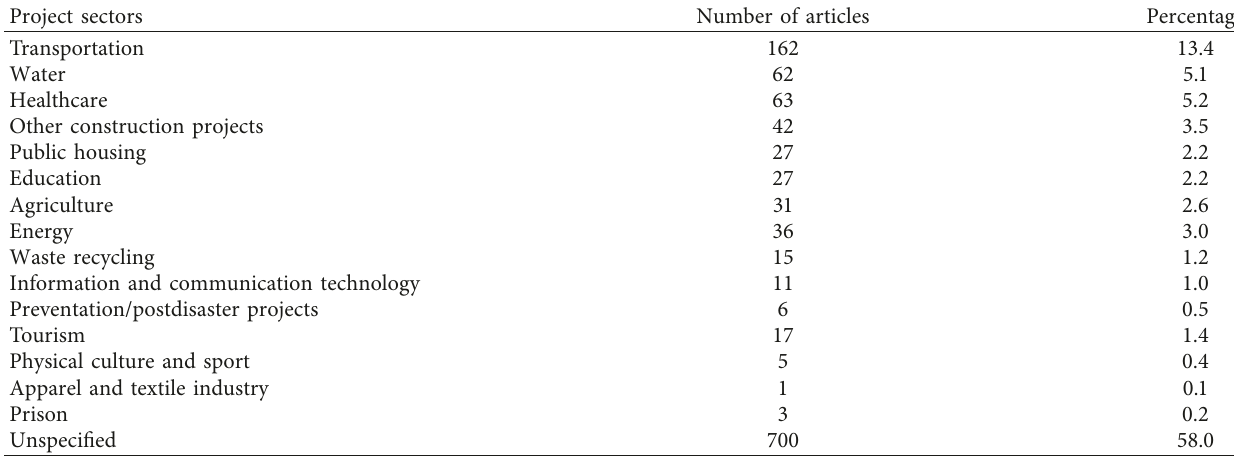
Table 9: Summary of project sectors in the PPP